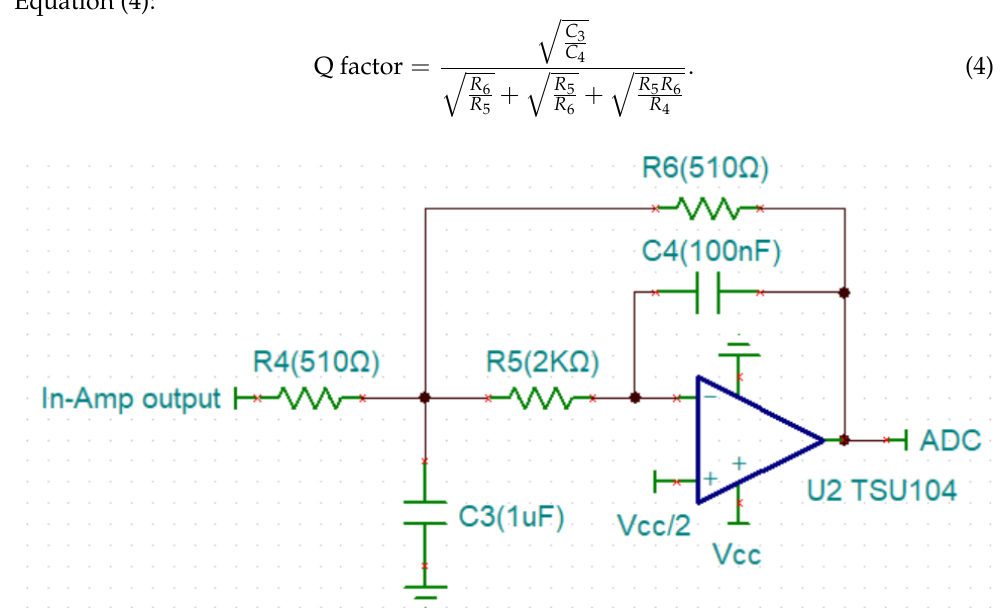
Figure 10. Architecture of the MFB low-pass filter.